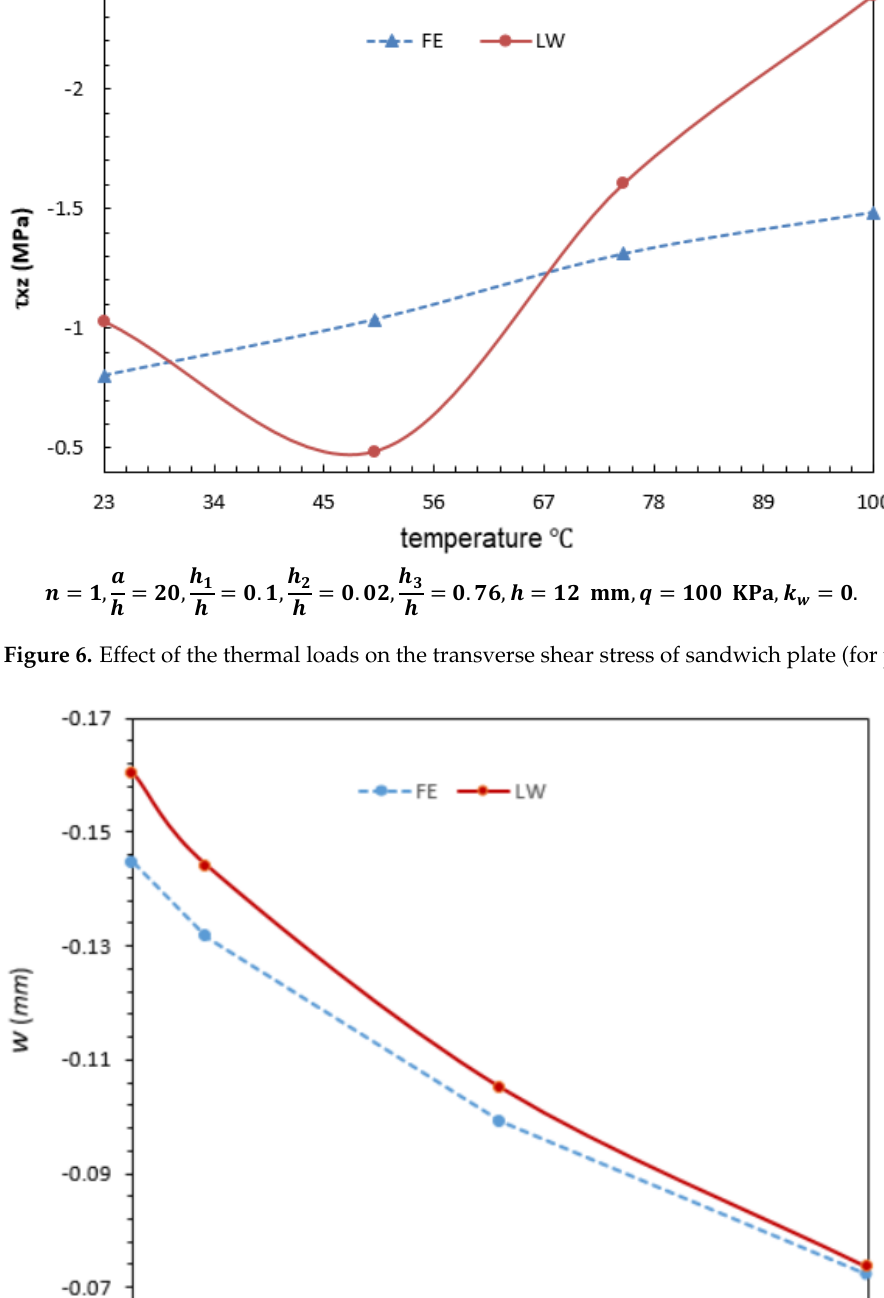
Figure 5. Effect of the thermal loads on the maximum normal stresses of sandwich plate (for point 6).